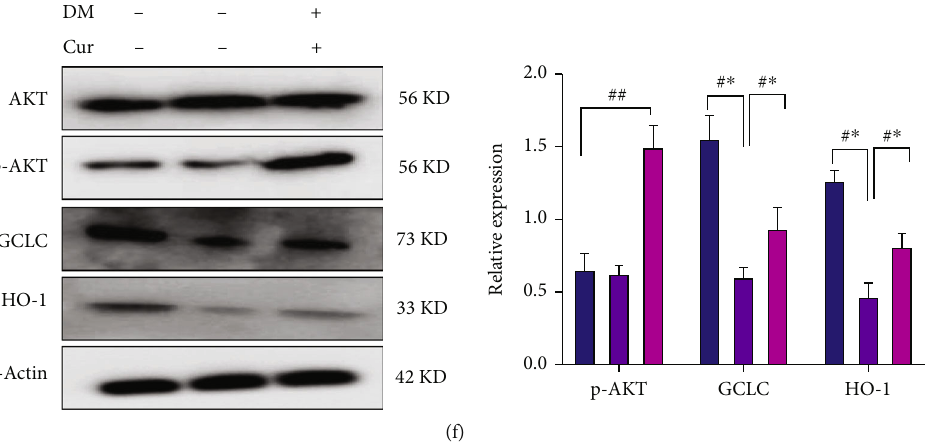
Figure 4: Curcumin promotes the translocation of Nrf2 into the nucleus through the AKT pathway. Glu: glucose; DM: diabetic rat; Cur: curcumin; the dose of curcumin used in cell experiments was 14 μ M; the dose used in the rat experiment was 200 mg/kg/day. (a) AKT/ Nrf2/ARE pathway protein expression levels in cardiomyocytes were detected using western blotting. (b) The expression of the Nrf2 protein in the nucleus (nu-Nrf2) of cardiomyocytes was detected by western blotting. (c) Expression levels of immuno fl uorescence- labeled Nrf2 in di ff erent parts of cells (20x). (d) The expression sites of the Nrf2, DAPI, and KEAP1 proteins were analyzed for fl uorescence colocalization using ImageJ. (e) Western blotting detection of Nrf2 protein expression in the nucleus of rat myocardial tissue. (f) Western blotting was performed to detect the expression levels of proteins in the AKT/Nrf2/ARE pathway in rat myocardial tissue. ∗∗ P < 0 : 001 : high-glucose group vs. normal medium and curcumin treatment group. # P < 0 : 001 : curcumin-treated group vs. curcumin-treated group. ^^ P < 0 : 001 : diabetes group vs. control group and curcumin-treated group. ^ ∗ P < 0 : 001 : curcumin-fed vs. no curcumin (in diabetic rats). Values are expressed as the mean ± standard